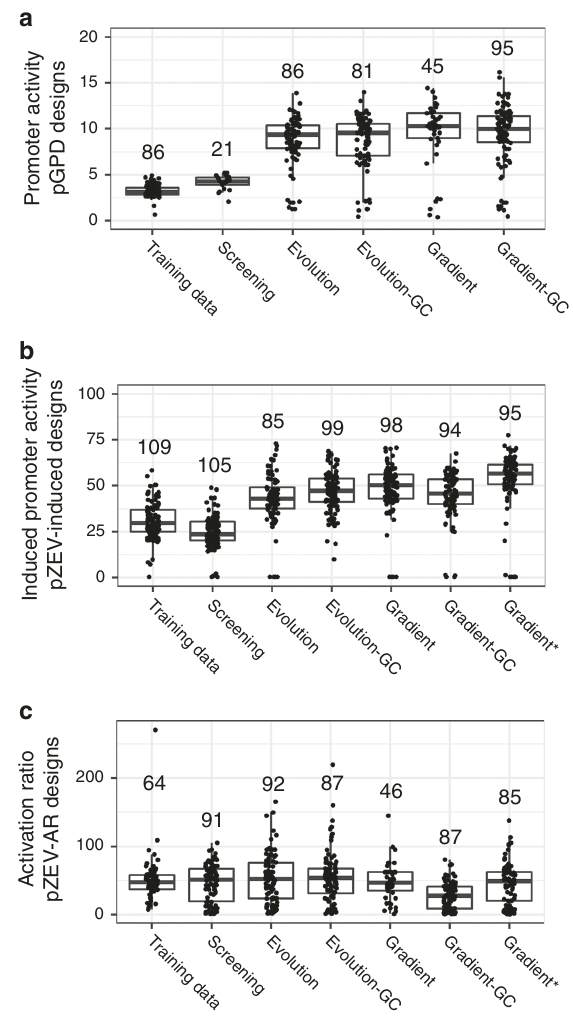
Fig. 3 Performance of designed promoter sets in validation FACS-seq experiment. In panels ( a − c ), boxes represent interquartile ranges; the bar within each box indicates the median. Whiskers extend to the furthest observation within 1.5 interquartile ranges of the nearest box edge. Numbers over boxplots indicate the number of sequences measured in FACS-seq in each promoter set. Promoter activities are shown here on a linear scale, and were transformed to a scale comeasureable with the results of individual promoter testing using a linear model fi t to promoter activities measured by FACS-seq and by individual testing for a set of promoters spanning a range of expression activities. a FACS-seq measurements of promoter activities for P GPD promoter sets